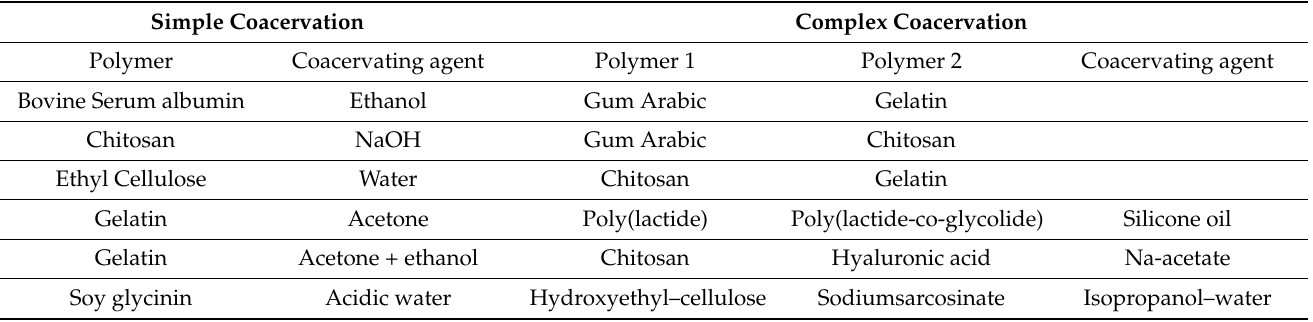
Table 1. An appraisal list of some simple and complex coacervate-forming